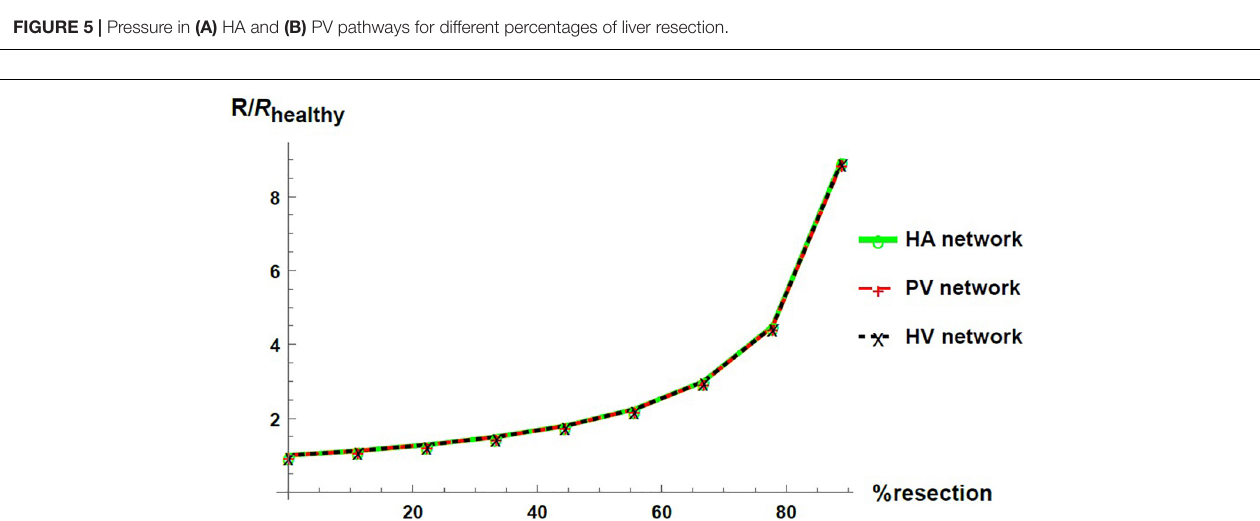
FIGURE 6 | Networks resistance as a function of the resection percentage for HA (green), PV (red) and HV (black) networks. The resistance is normalized by its corresponding value in the healthy